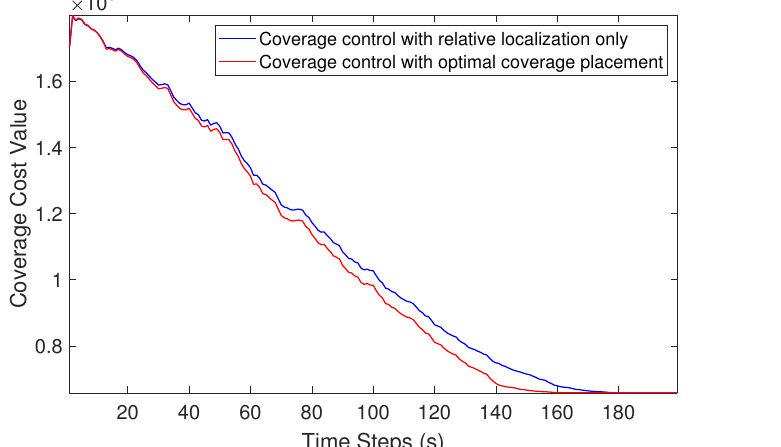
Figure 7. The change in coverage cost value.